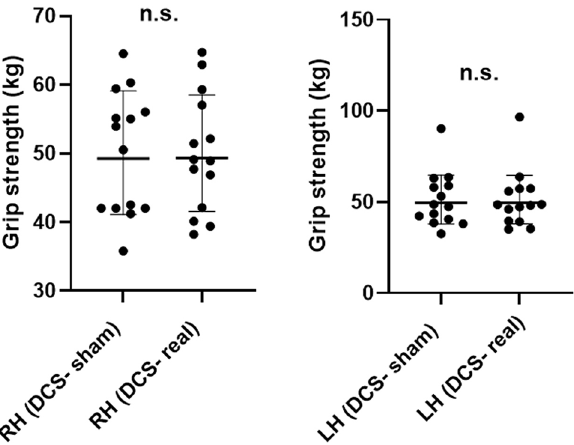
Figure 5. Dot plots representation of differences in grip strength of participants between real and sham DCS (RH: Right hand; LH: Left